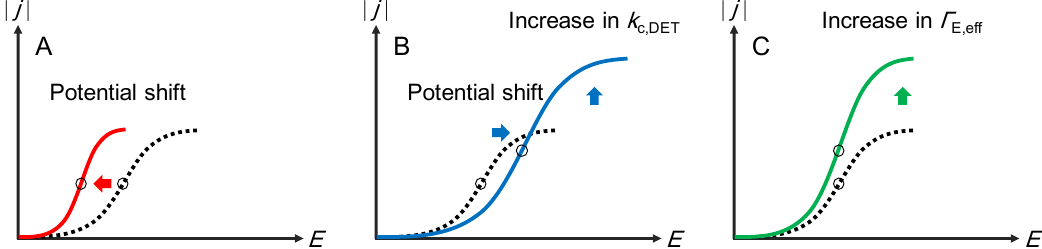
Figure 4. Illustrative drawing of the effect of mutations on steady-state bioelectrocatalytic waves in the DET-type bioelectrocatalysis of “substrate oxidation”. ( A ) Negative potential shift in the formal potential of the electron-donating site of the DET-type redox enzyme reactions, in which the intramolecular electron transfer is not the rate-determining process in the enzymatic catalytic reaction. ( B ) Positive potential shift in the formal potential of the electron-donating site of the DET-type redox enzyme reactions, in which the intramolecular electron transfer is the rate-determining process in the enzymatic catalytic reaction, and ( C ) downsizing without any change in the intrinsic enzymatic activity.